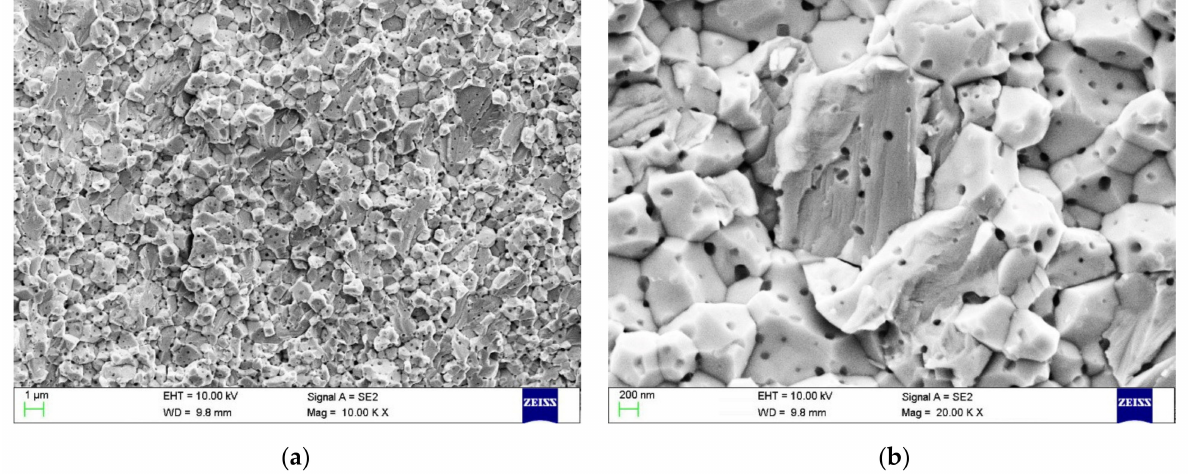
Figure 8. ( a , b ) FESEM images of the fractured surfaces of the sintered W-0.5TiC alloys. It has been studied extensively that the size and distribution state of the introduced carbide or oxide particles have significant influences on the microstructure and mechanical performances of the particle dispersed tungsten alloys. The desired microstructure for particle dispersed tungsten alloys is that the introduced second-phase particles are kept in nano range and uniformly dispersed both in tungsten grain interiors and at tungsten grain boundaries, and simultaneously the tungsten grains are as fine as possible. Firstly, the particles in nano range dispersed within tungsten grains can generate, pin down, and accumulate dislocations within the grains, resulting in the improved mechanical proper- ties, especially tensile properties. Secondly, the particles dispersed at the tungsten grain boundaries can hinder the migration of grain boundaries and inhibit the grain growth under high-temperature conditions, finally resulting in the refined tungsten grains after sintering and the increased recrystallization temperature. It has been reported that the refined tungsten grains can significantly increase the areas of grain boundaries and reduce the concentration of impurity atoms (especially O) at the tungsten grain boundaries [10]. Therefore, the detrimental effect of impurity atoms on tungsten grain boundary can be moderated. Thirdly, the particles located on tungsten grain boundaries can lead to